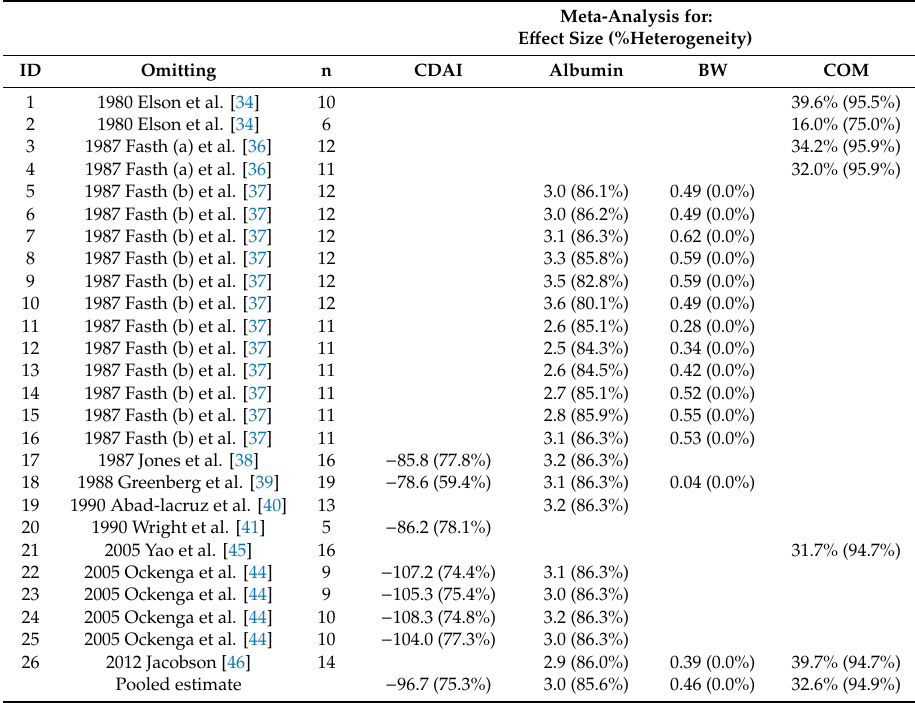
Table 3. Influence analysis in a meta-analysis using the leave-one-out method (Random effect).